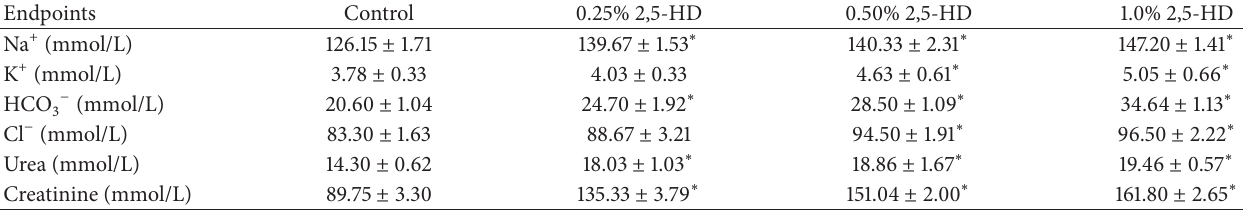
The data are expressed as mean ± SD for eight animals per group. ∗ 𝑃 < 0.05 against